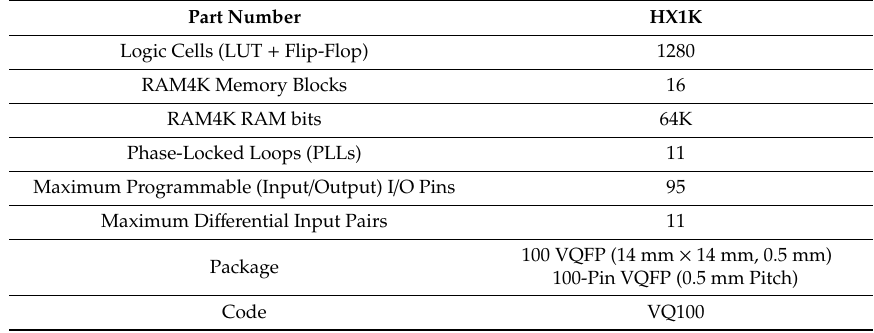
Figure 18. Block diagram of the wireless sensor node: UCODALIB. Table 3. Information of the FPGA iCE40 of Lattice Semiconductor (Source: